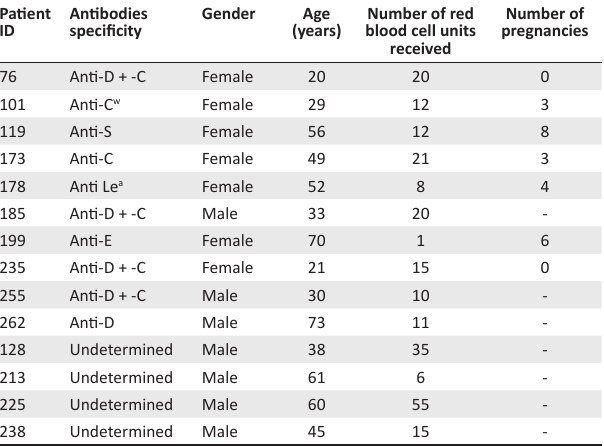
TABLE 2: Characteristics of patients with red blood cell alloimmunisation, Yalgado Ouedraogo Teaching Hospital of Ouagadougou, Burkina Faso, 2018. † Patient ID